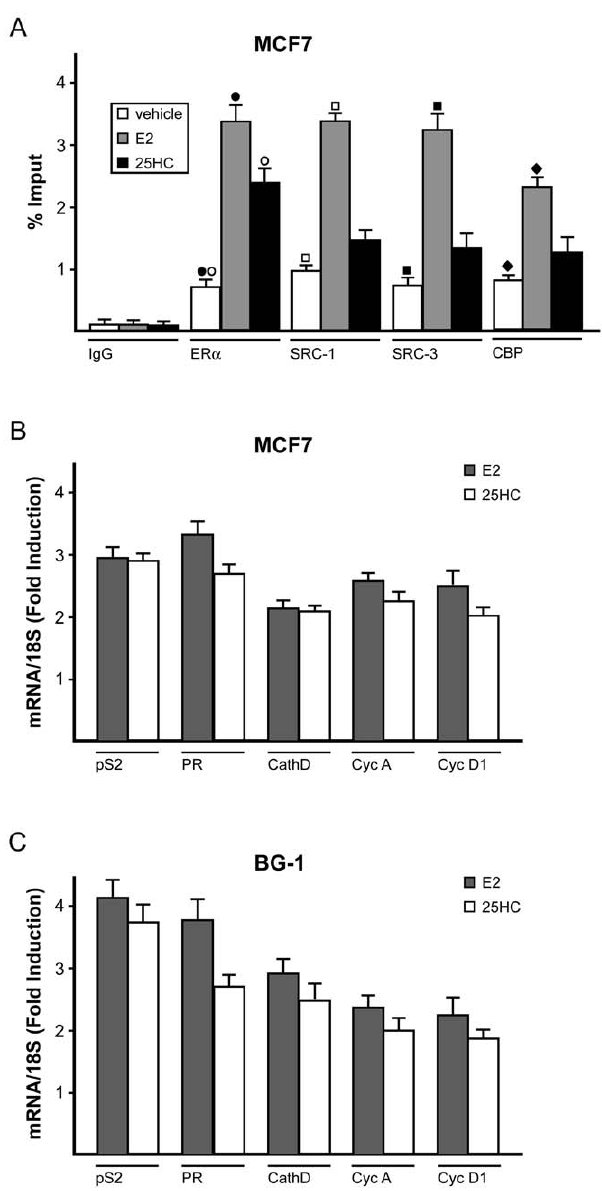
Figure 3. 25HC up-regulates the expression of estrogen target genes. (A) E2 and 25HC induce the recruitment of ER a to the ERE site located in the pS2 promoter sequence in MCF7 cells. Cells were treated for 1 h with vehicle, E2 (10nM) or 25HC (1 m M) and submitted to the chromatin immunoprecipitation procedure using anti-ER a or nonspe- cific anti-IgG antibodies. For Re-ChIP assays, anti-SRC-1, SRC-3 and CBP antibodies were used. The amplified sequences were evaluated by real- time PCR. (B–C) evaluation of mRNA expression of pS2, Progesterone Receptor (PR), Cathepsin D, Cyclin A and Cyclin D1 by real-time PCR in MCF7 and BG-1 cells. Cells were treated for 24h with 10nM E2 and 1 m M 25HC. Results obtained from experiments performed in triplicate were normalized for 18S expression and shown as fold change of RNA expression compared to cells treated with vehicle. Each data point represents the mean 6 SD of three experiments performed in triplicate. ( N ), ( u ), ( & ), ( % ) ( ¤ ) indicate p , 0.05 for cells receiving vehicle (–) versus